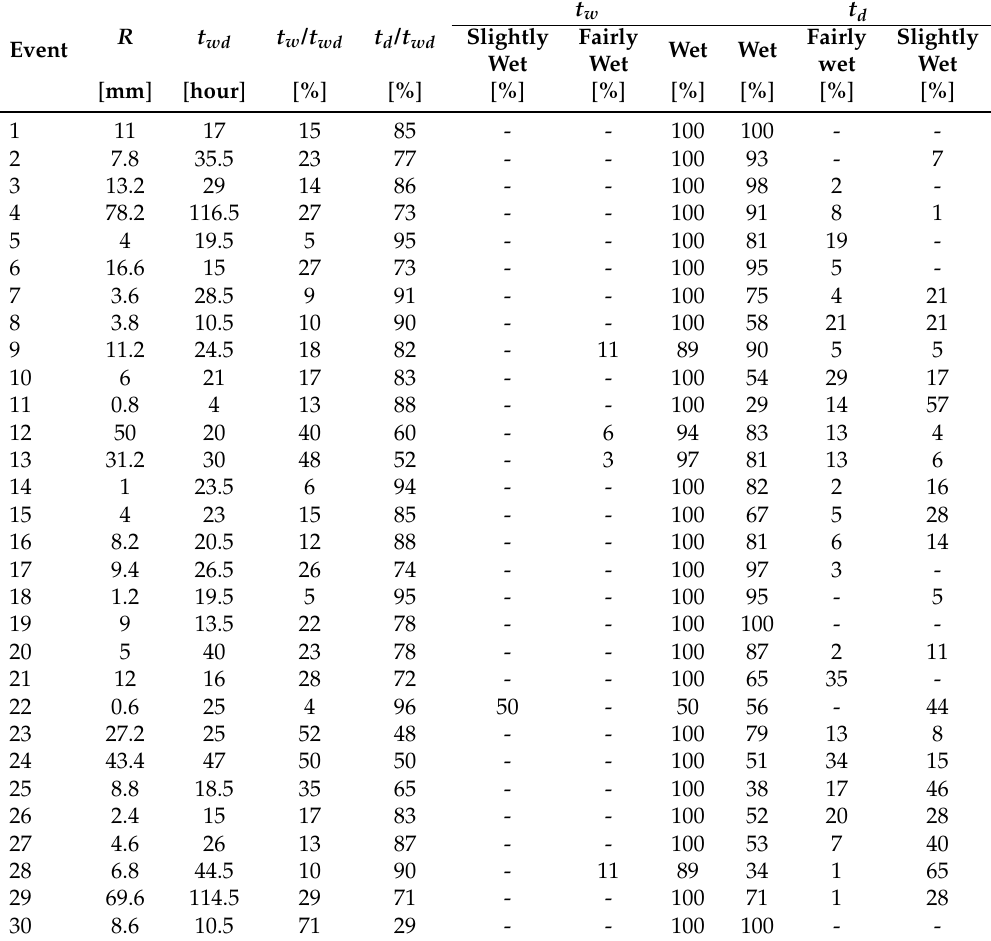
Table A1. Characteristics of each wetting–drying event described by the total rain ( R ) during event, length of the event ( t wd ), length of wetting phase ( t w ), length of drying phase ( t d ) and contribution of each canopy condition in Juvenile during the measurement period of